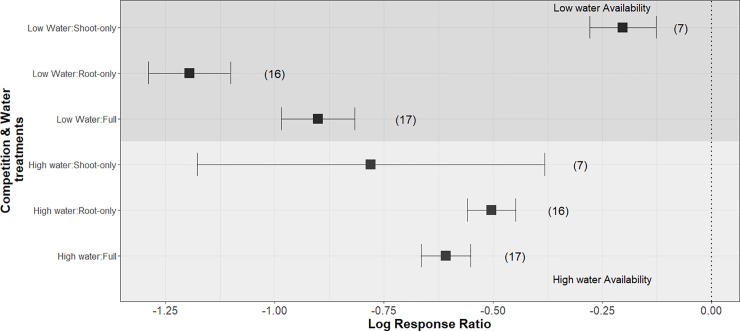
Effects of water availability and competition on plant growth.Meta-estimates (square points) and 95% confidence intervals. Smaller values indicate intense competition, while larger values indicate weaker competition. Sample sizes of lnRR values are in parentheses.